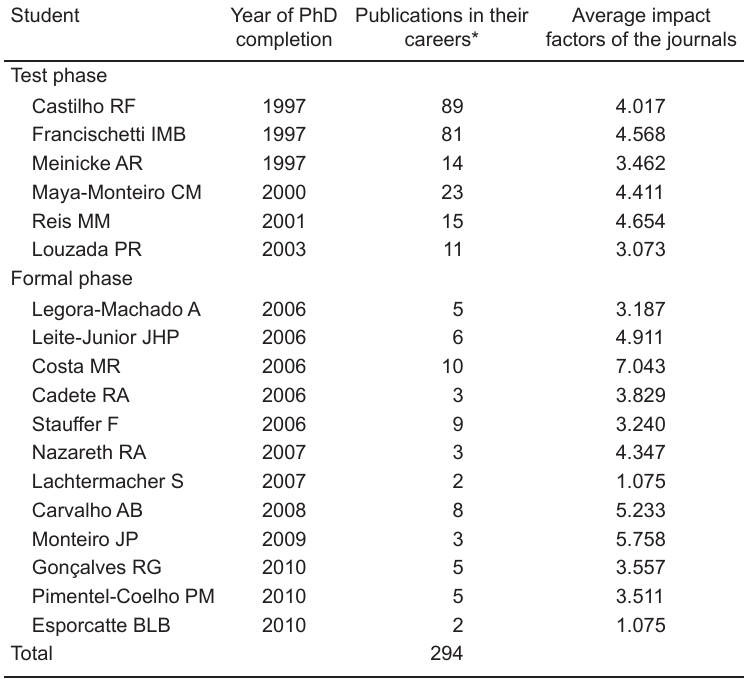
Table 1. List of students who completed the MD/PhD program of the Federal Univer- sity of Rio de Janeiro and number of publications in their careers.